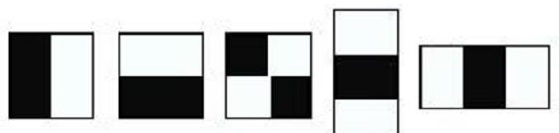
Figure 10. Several instances of rectangular Haar features. The feature response when applied on an image region equals to the sum of pixels under the shaded regions subtracted from the sum of pixels under the white region.